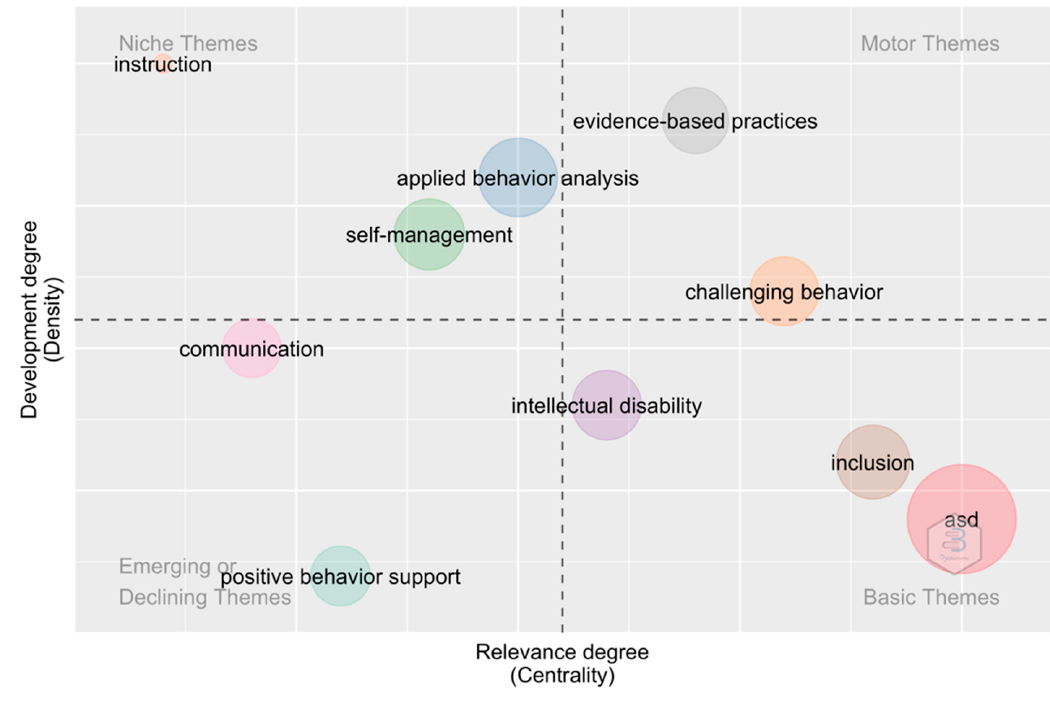
Figure 8. Strategic